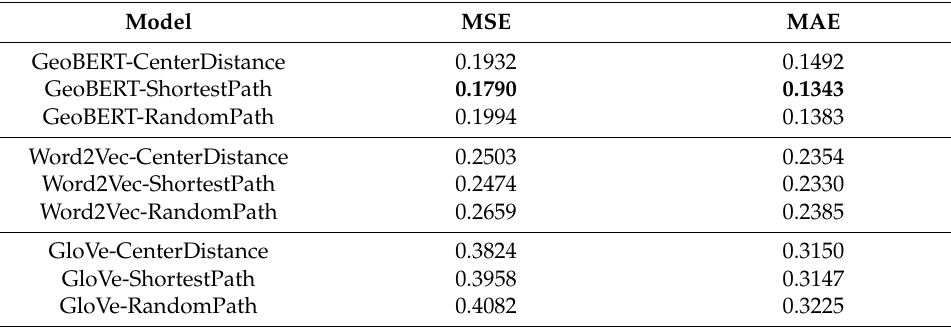
Table 9. Evaluation on POI number prediction .